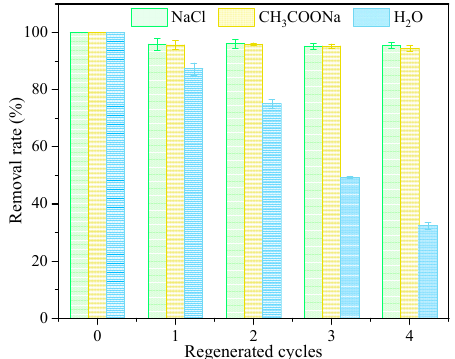
Figure 8. Reusability of composite FAU (HN-WSB-Z) for Cu(II) removal. (Conditions: T = 298 K, t = 180 min, C 0 = 10 mg/L, dosage = 0.2